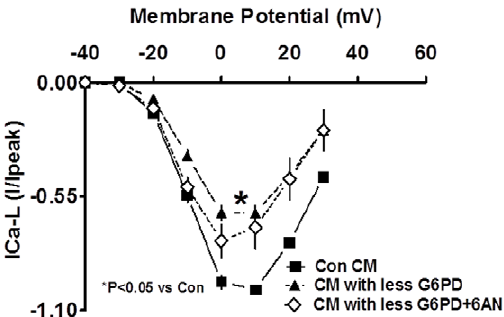
Figure 7. I–V relationships show that I Ca-L amplitudes were significantly reduced in the cardiac myocytes (CM) with less G6PD than the control CM.